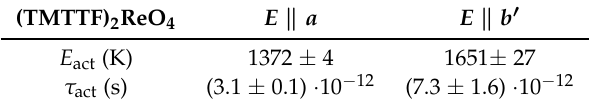
Table 4. Parameters of the activated behavior observed in τ 0 for two crystal directions of (TMTTF) 2 ReO 4 .